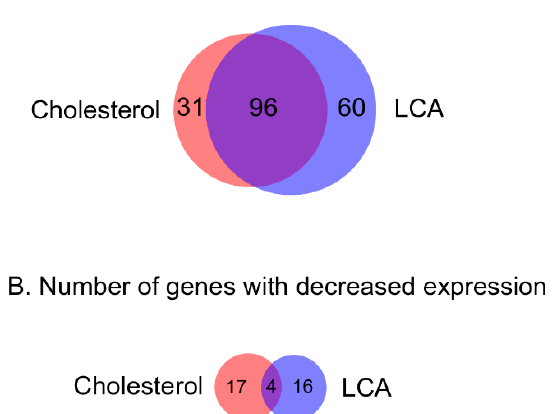
Figure 4. Venn diagram for the N. simplex VKM Ac-2033D with the number of genes that changed expression in response to cholesterol or LCA. (A) Genes with increased expression. (B) Genes with